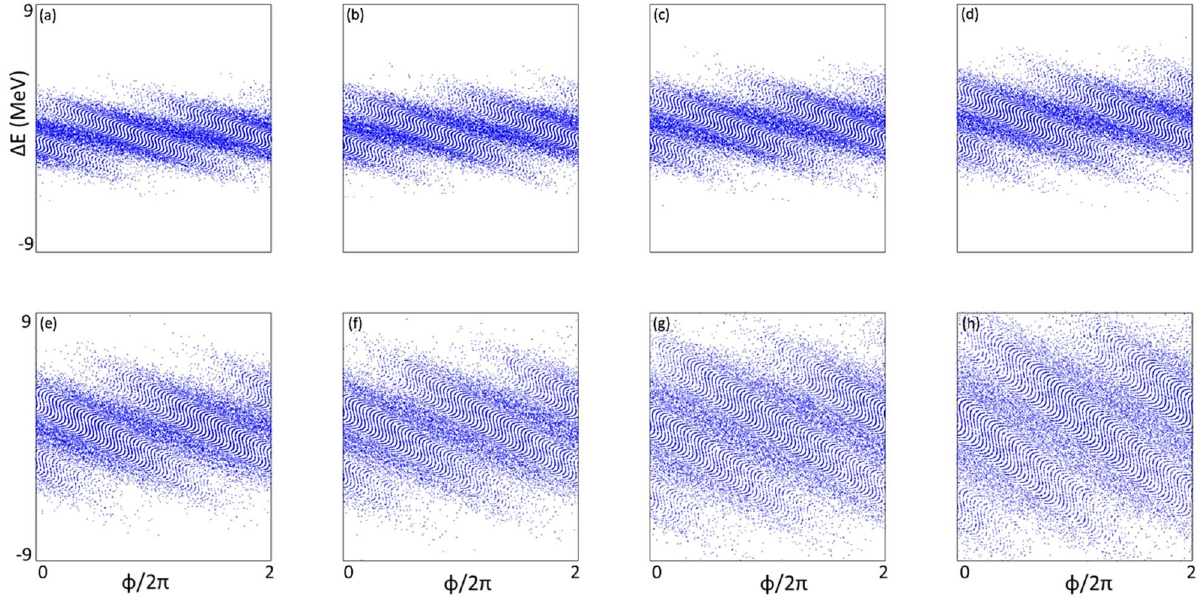
Figure 5. Longitudinal phase spaces corresponding to the energy modulations of stage 1 with the values of 0.667 ( a ), 1.000 ( b ), 1.333 ( c ), 1.667 ( d ), 2.000 ( e ), 3.000 ( f) , 4.000 ( g ), and 5.000 ( h ) are plotted respectively.